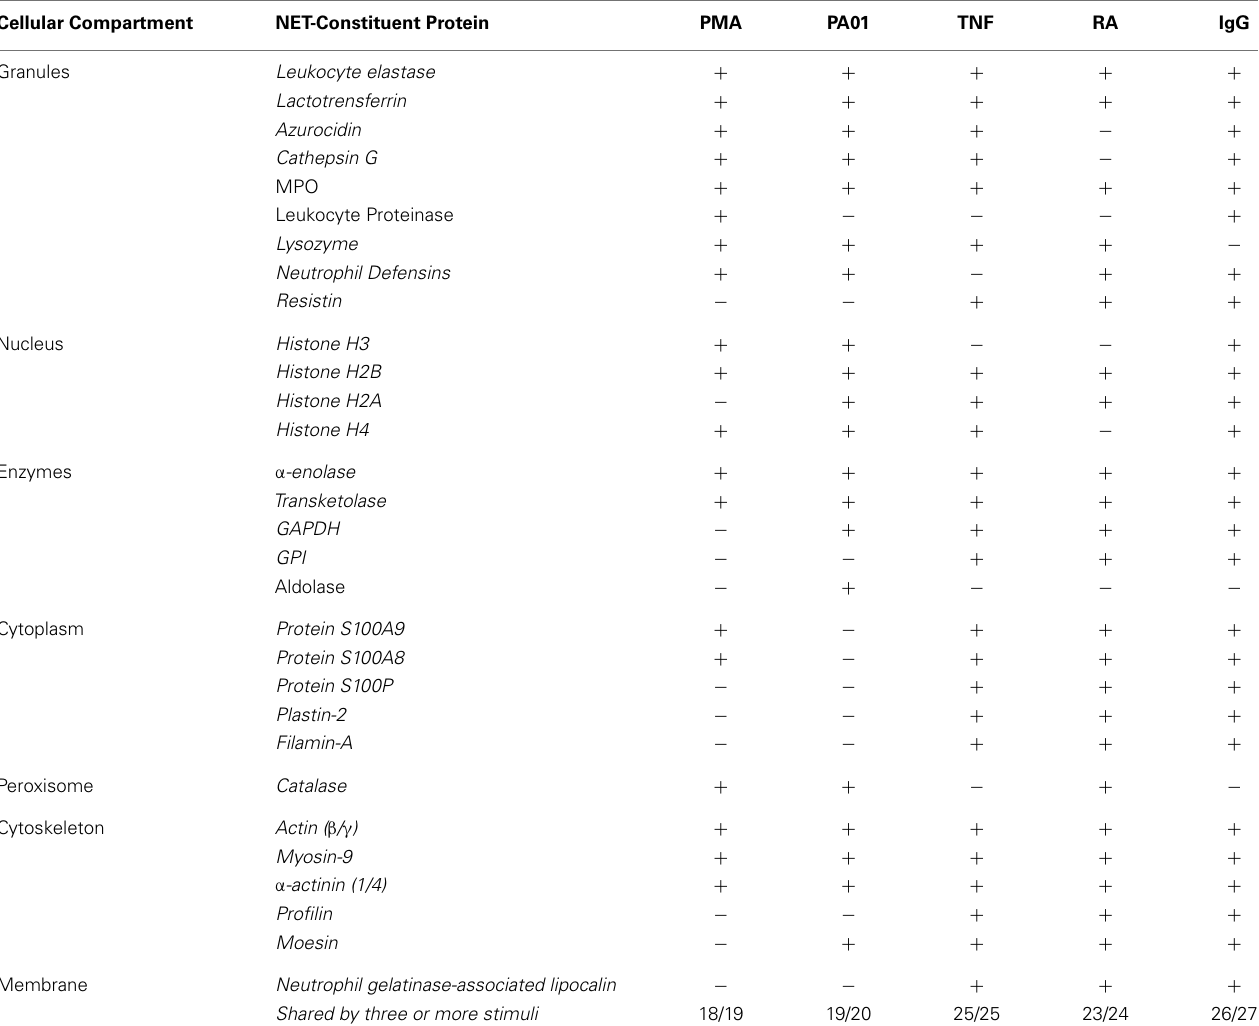
Table 1 | NET-reported proteomes